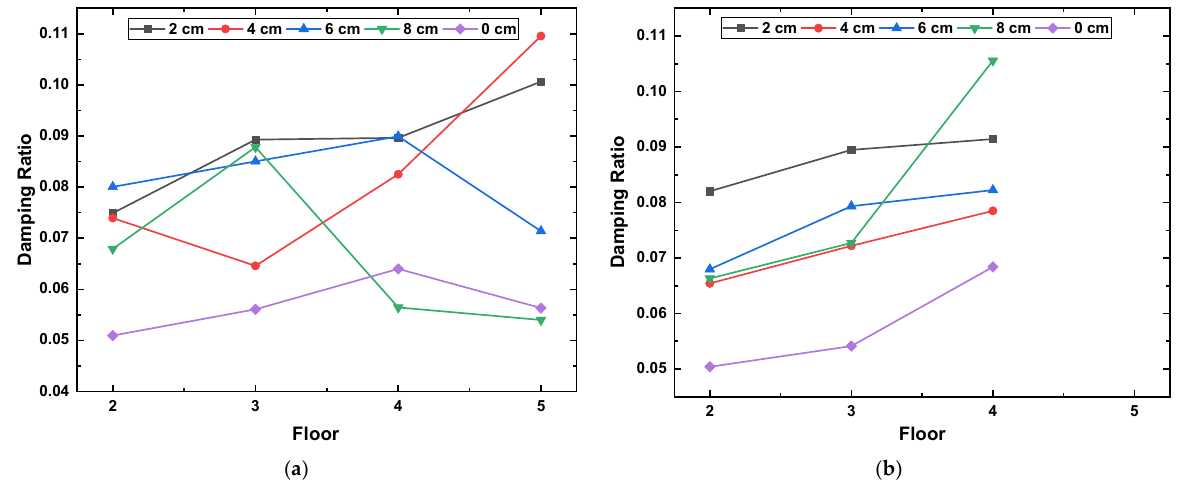
Figure 12. The calculated damping ratio based on the measured accelerations. ( a ) Top floor measurement; ( b ) Tank floor measurement.